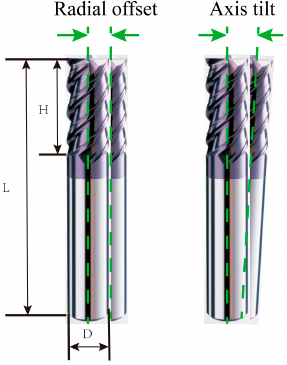
Figure 2. Tool runout: (a) radial offset; (b) axis tilt.